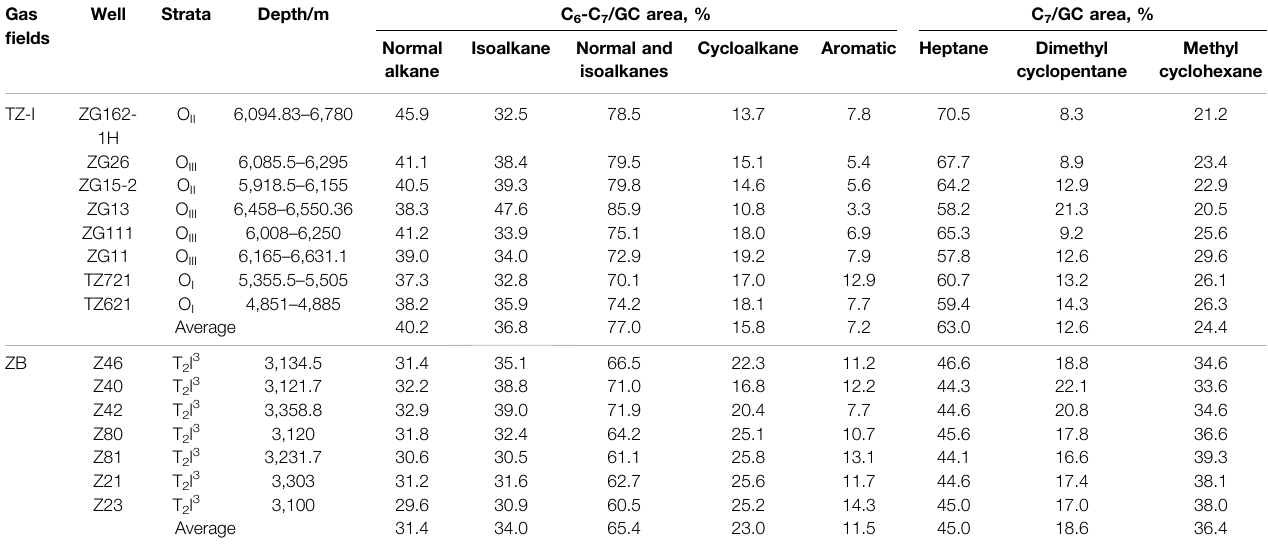
TABLE 2 | The relative contents of C 6 -C 7 light hydrocarbons of natural gases from the TZ-I and ZB gas fi elds. Gas fi elds